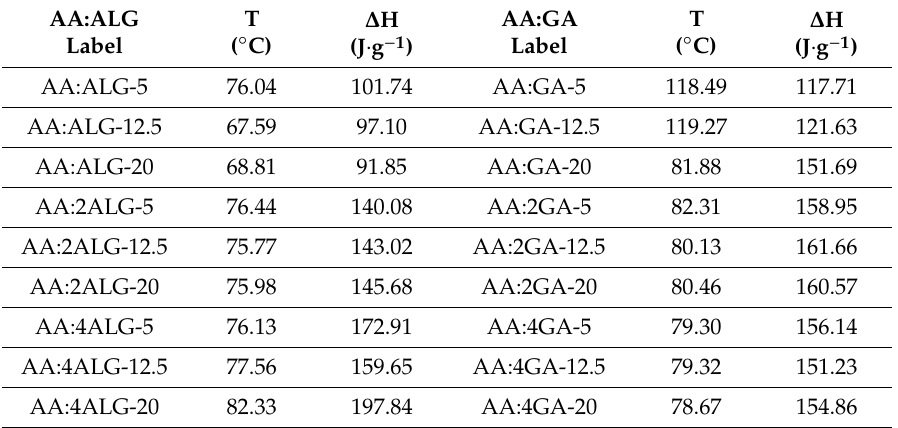
Figure 6. DSC first heating thermogram of the AA:ALG (left) and AA:GA-based (right) microparticles. Table 6. Peak temperatures and enthalpies of the first heating thermogram for the AA:ALG and AA:GA-based